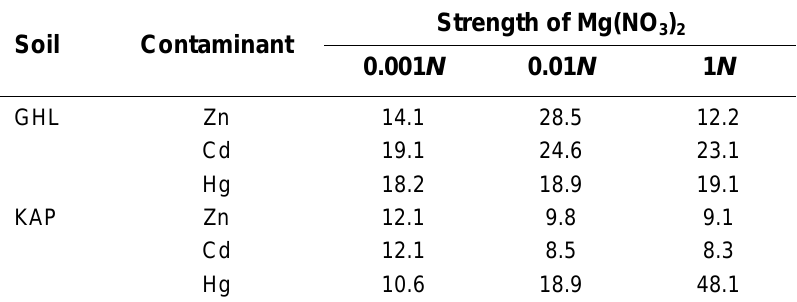
) 3 2 Strength of Mg(NO